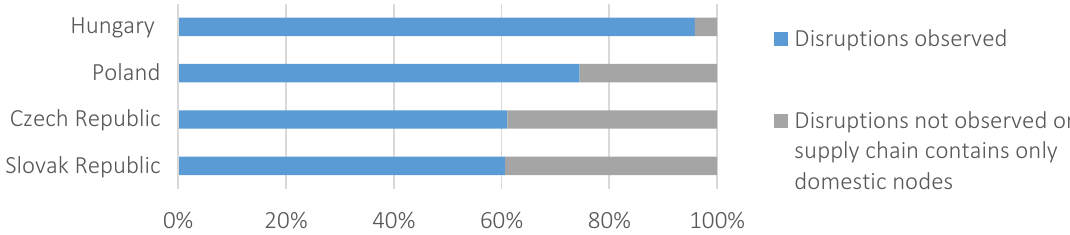
Figure 2. Disruptions in international supply chain nodes based on country of